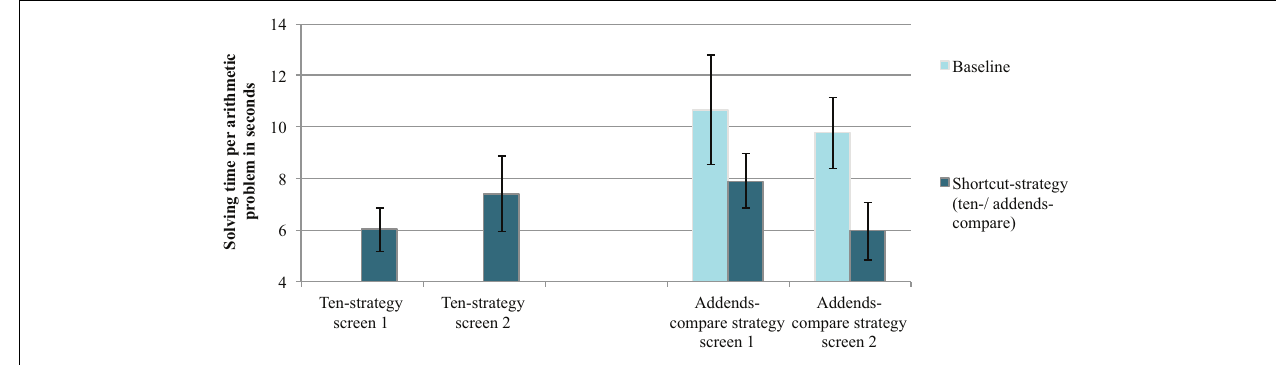
FIGURE 1 | Mean calculation time per arithmetic problem in Experiment 1. Error bars indicate the standard error of the mean.